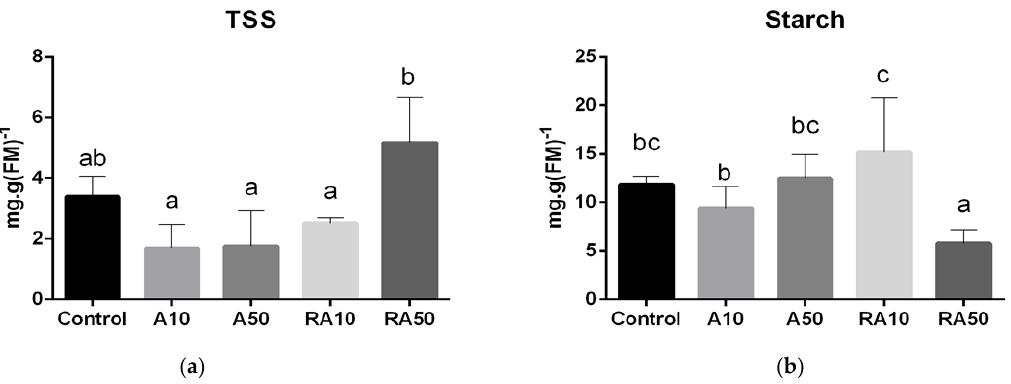
Figure 2. Effects of A and RA treatments on the levels of ( a ) TSS: total soluble sugars; ( b ) starch. Different letters mean significant differences ( p < 0.05).